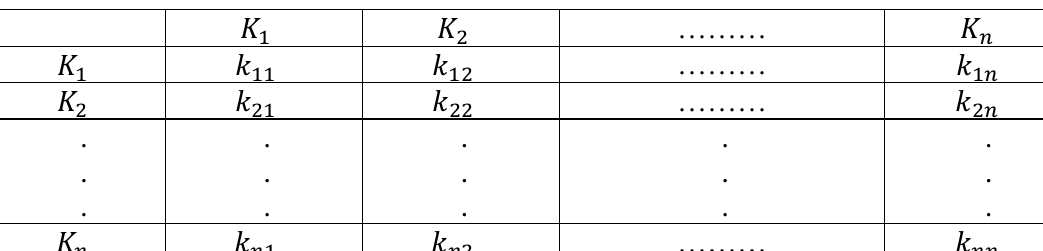
Table 1: Pair-wise